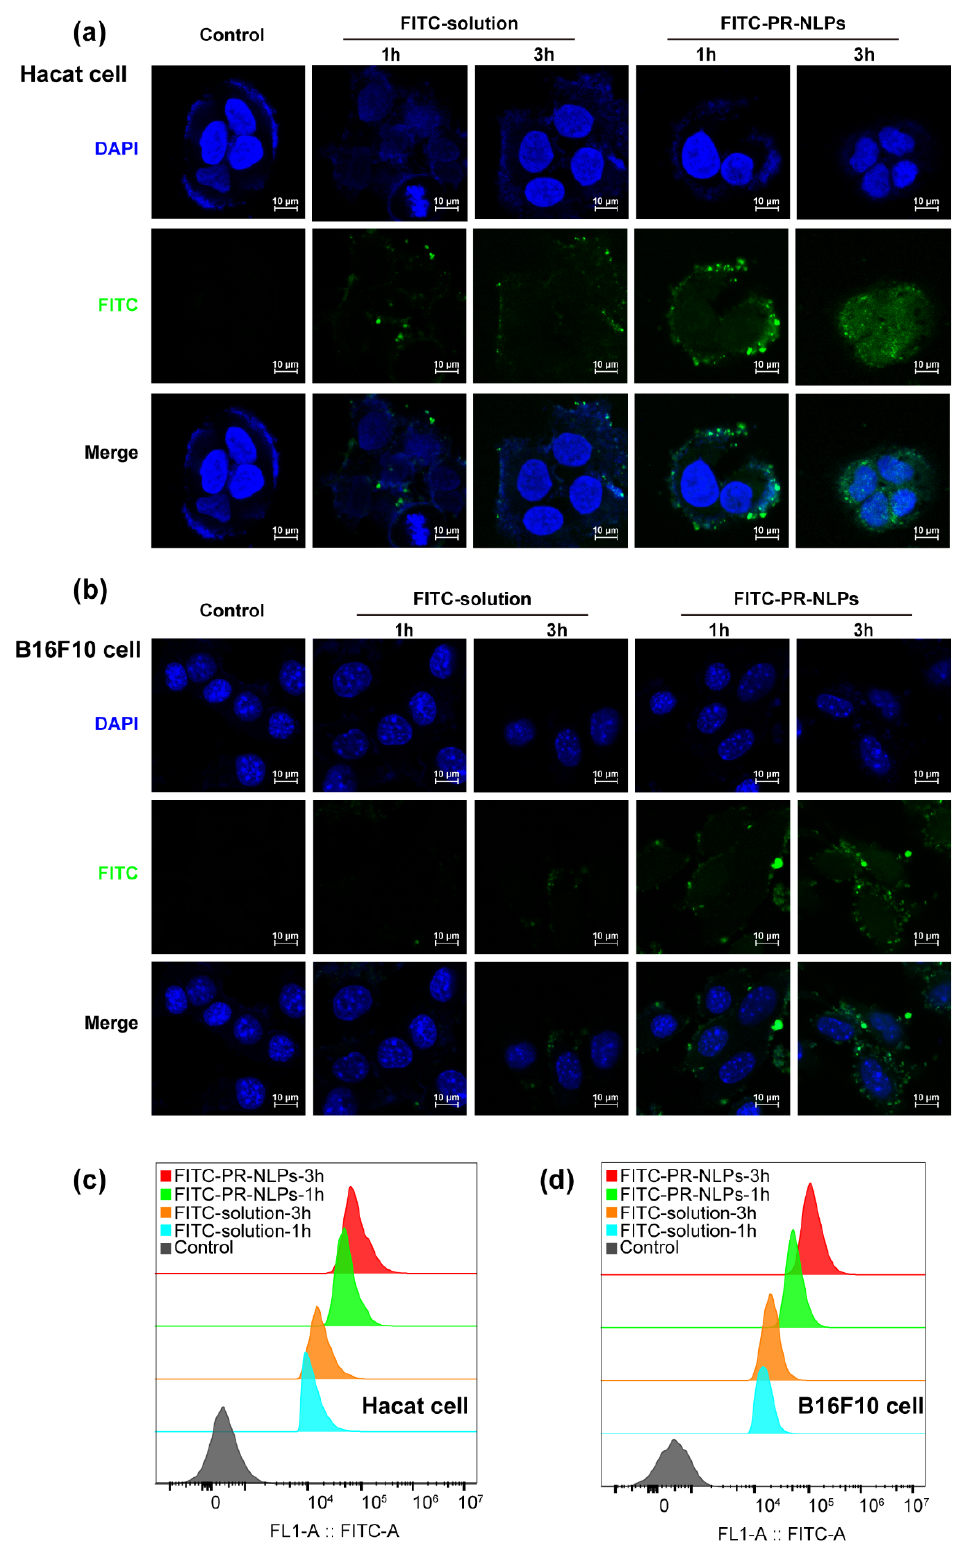
Figure 9. Cellular uptake of FITC or FITC-PR-NLPs. ( a ) Confocal laser scanning microscopy images of FITC solution and FITC-PR-NLPs in HaCaT cells. ( b ) Confocal laser scanning microscopy images of FITC solution and FITC-PR-NLPs in B16F10 cells. ( c ) FITC intensity in HaCaT cells treated with FITC solution and FITC-PR-NLPs. ( d ) FITC intensity in B16F10 cells treated with FITC solution FITC-PR-NLPs.